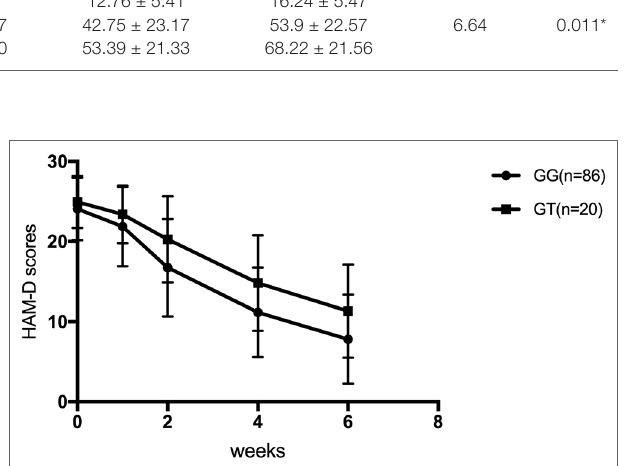
FIGURE 3 | HAM-D scores at the first, second, fourth, and sixth week (Rs2235040).